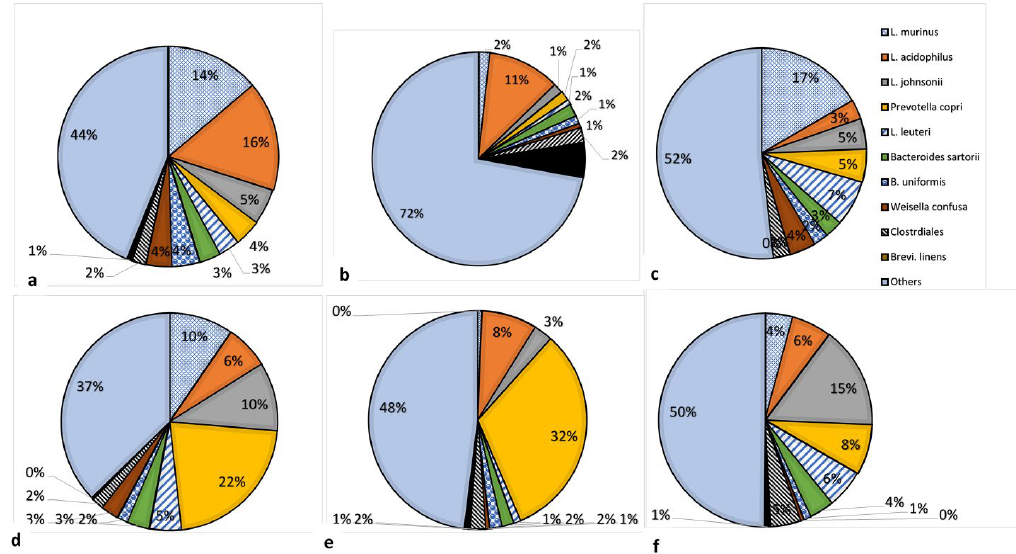
Fig. 2. Relative abundance of major bacterial species in the colonic flora of rat groups: (a) normal rats (b) untreated diabetic rats (c) rats treated with 200 mg/Kg bw G. latifolium (d) rats treated with 400 mg/Kg bw G. latifolium (e) rats treated with 800 mg/Kg bw G. latifolium (f) rats treated with glibenclamide. Note significant disruption of composition of flora of diabetic rats compared with groups treated with G. latifolium , in which there was increase in species associated with improved glucose metabolism. Dosage of 400 mg/Kg bw produced the best